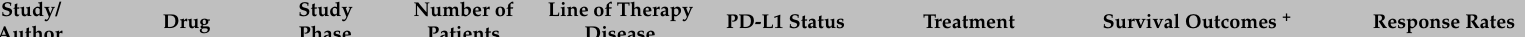
Table 1. Overview and results of clinical trials assessing immune checkpoint inhibitors in cervical cancer patients